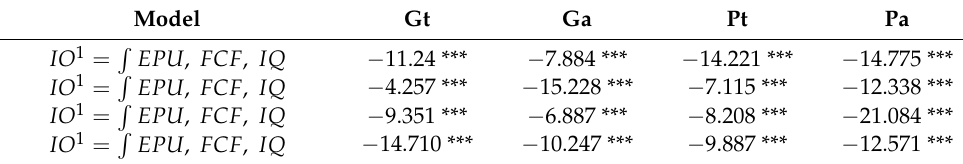
Table 10. Westerlund (2007)